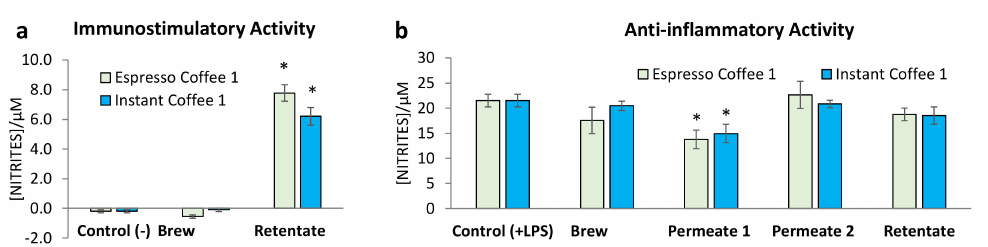
Figure 2. Murine macrophages nitrite production of raw 264.7 cells in culture medium: ( a ) immunostimulatory conditions and ( b ) anti-inflammatory conditions, where the samples were further treated with LPS. Each value represents the mean ± SEM from at least 3 experiments (* p < 0.01, compared to